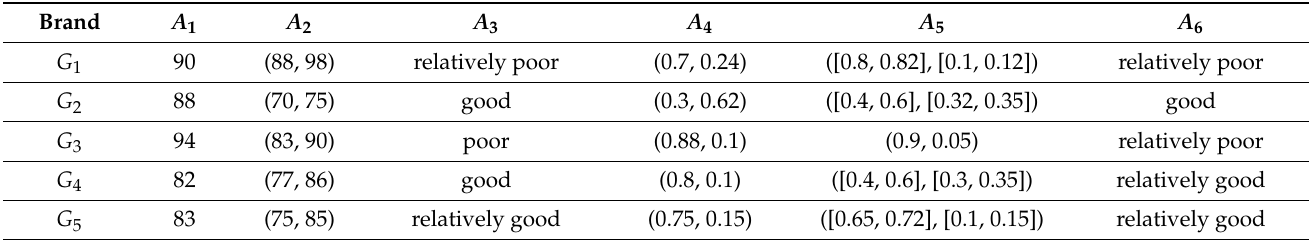
Table 4. The evaluation matrix of expert D 2